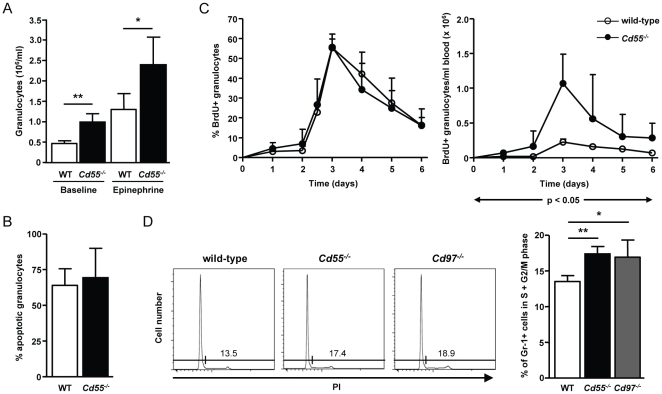

Cd55-/- and Cd97-/- mice have an increased granulopoietic capacity.(A) Blood was collected from wild-type and Cd55
-/- mice two days before and 30 min after i.p. injection of 0.25 mg/kg epinephrine, and the number of granulocytes per ml blood was measured by flow cytometry. Bars and error bars represent the mean and SD of the number of granulocytes (n = 3-5). (B) PBL from wild-type and Cd55
-/- mice, cultured overnight at 37°C, were stained with Mitotracker and analyzed by flow cytometry. Shown is the mean and SD of the percentage of Mitotracker-negative apoptotic granulocytes (n = 4). (C) Blood was collected from wild-type and Cd55
-/- mice via vena saphena puncture at the indicated time points after a single i.p. injection of 5 mg BrdU. PBL were stained for Ly6G and BrdU and analyzed by flow cytometry (left panel). The mean and SD of the percentages (left panel) and absolute numbers (right panel) of BrdU-positive granulocytes are depicted (n = 3–5). (D) Wild-type, Cd55
-/-, and Cd97-/- bone marrow cells were harvested and analyzed by flow cytometry for dividing cells. To the left, representative histograms showing the percentage of granulocytes with > 2N DNA content in wild-type, Cd55
-/-, and Cd97
-/- mice are provided. To the right, the mean and SD of the percentage of granulocytes with > 2N DNA content is depicted (n = 3–4). One of two comparable experiments is shown. *, p<0.05 and **, p<0.005